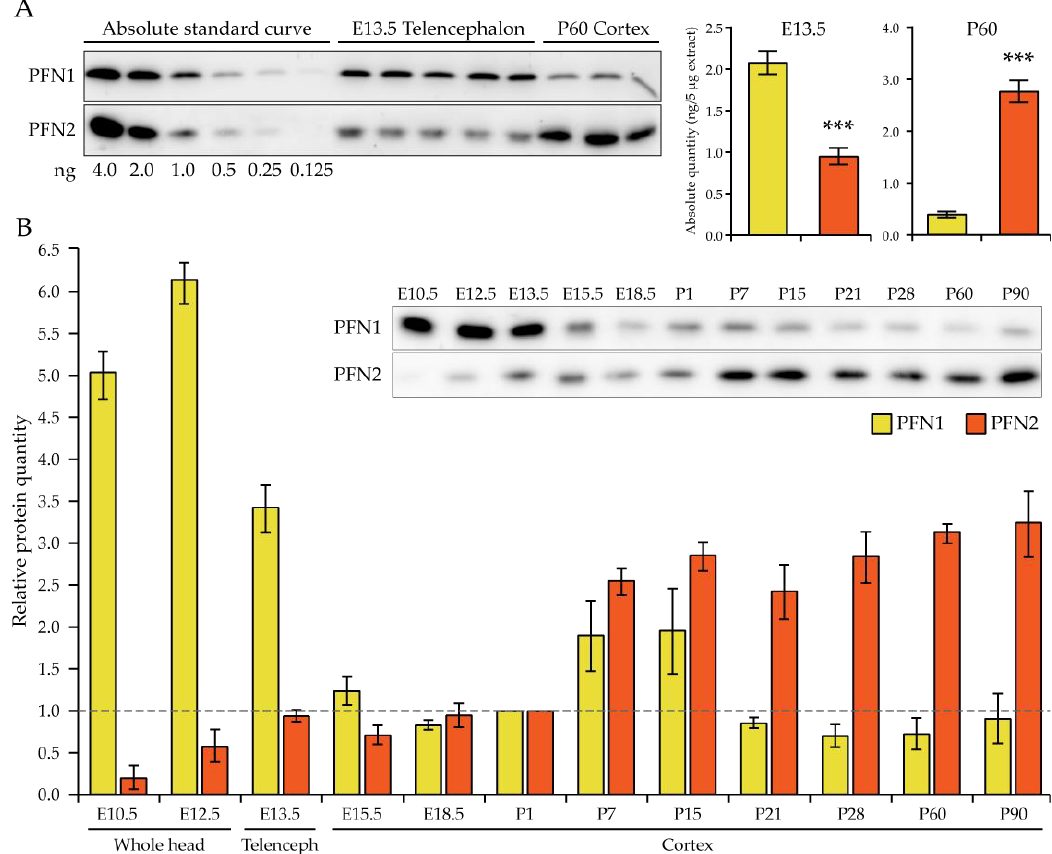
Figure 1. Profilin 1 and 2 expression in the neural tissue. ( A ) Western blots and relative histograms representing the absolute quantification of profilin 1 and profilin 2 in total protein extracts from E13.5 telencephali and P60 cortices from C57Bl/6NCrl mice, using 4, 2, 1, 0.5, 0.25, and 0.125 ng of the respective recombinant profilin for the standard curve. To avoid membrane or ECL signal saturation artefacts, only 2.5 µ g of protein extract was loaded onto the polyacrylamide gel, except for P60 cortices in the PFN1 blot, where 5 µ g was used due to the low PFN1 expression. Telencephalic and cortical extracts were calibrated with Coomassie staining of the membrane. At E13.5, profilin 1 is double the level of profilin 2 (Welch’s double-sided t -test, p < 0.001), whereas, in P60 cortices, profilin 2 is sevenfold the level of profilin 1 (Welch’s double-sided t -test, p < 0.001); n = 5 E13.5 wt telencephali, n = 3 wt P60 cortices. ( B ) Relative quantification histogram